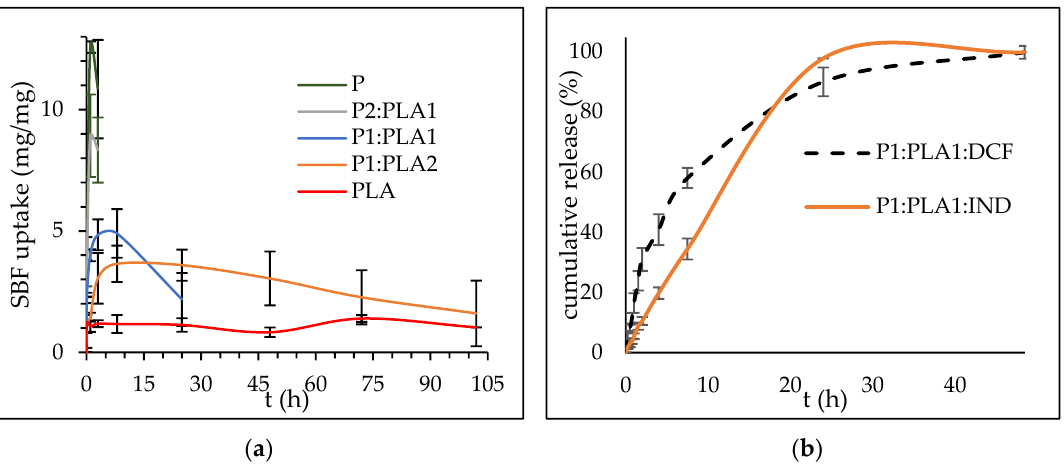
Figure 5. ( a ) SBF uptake of the reference and hybrid samples, ( b ) DCF and IND dissolution from the P1:PLA1:DCF and P1:PLA1:IND samples. Each sample was measured in duplicate, and the standard deviation is expressed as error bars.